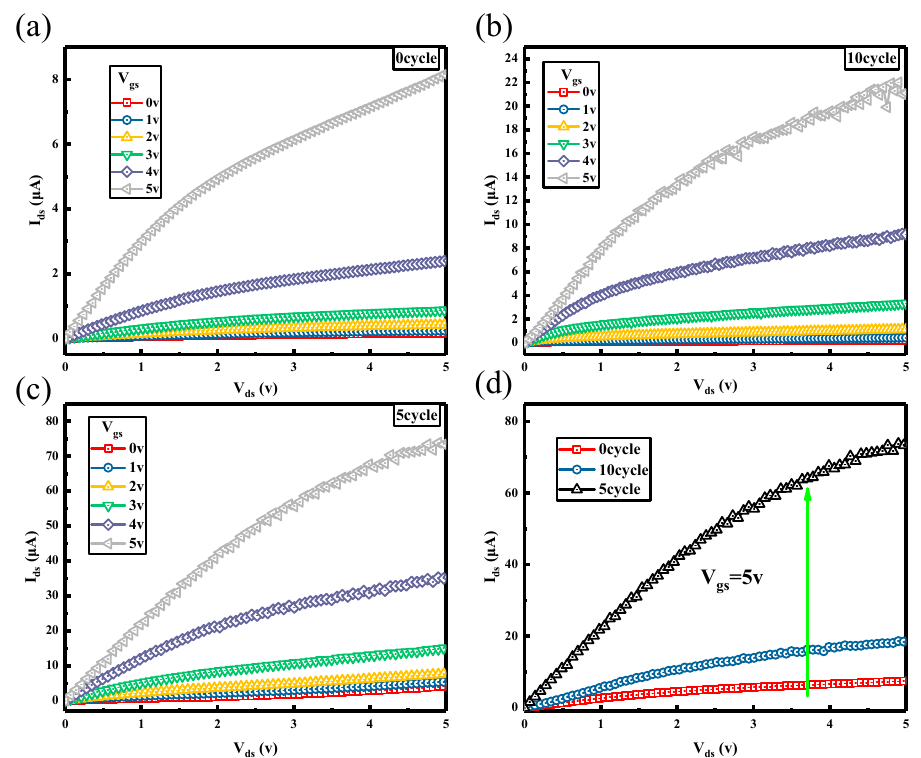
Figure 4. The normalized current-voltage characteristics of the thin film transistor devices on PET substrate with different cycle of TiO 2 . ( a ) The thin film transistor devices on PET substrate with 0 cycle of TiO 2 . ( b ) The thin film transistor devices on PET substrate with 10 cycles of TiO 2 . ( c ) The thin film transistor devices on PET substrate with 5 cycles of TiO 2 . ( d ) Shows the normalized current-voltage characteristics of the thin film transistor devices on PET substrate whose I ds of 0, 5, 10 cycles at V gs = 5 v.